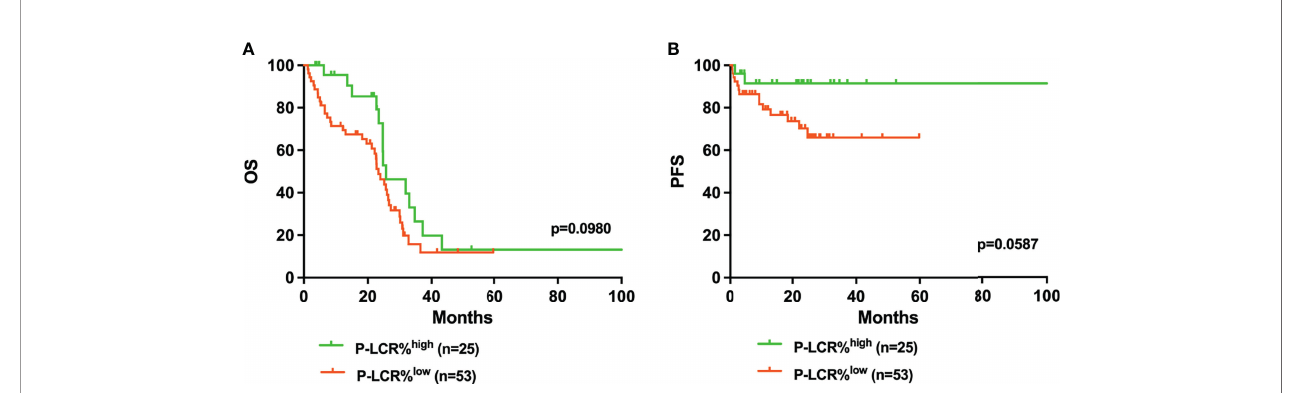
FIGURE 3 | Higher P-LCR was not associated with better OS (A) and better PFS (B) in lower risk MDS groups (lower risk MDS group was de fi ned as IPSS=low risk